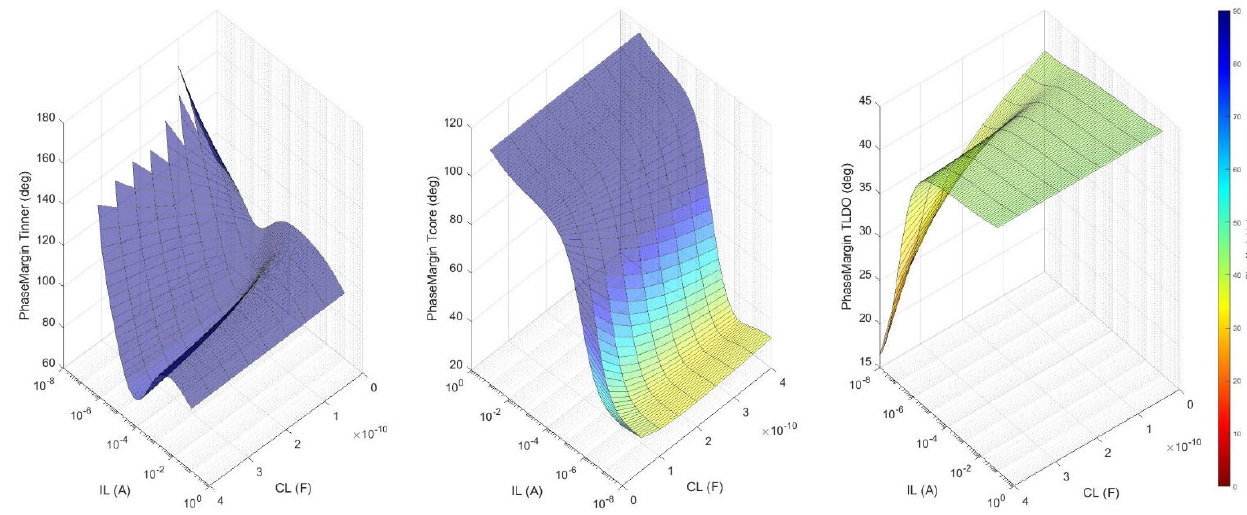
Figure 8. The phase margin for T INNER , T CORE , and T LDO when CL and IL are swept over their entire range of values: CL = 0 to 400 pF and IL= 0 to 100